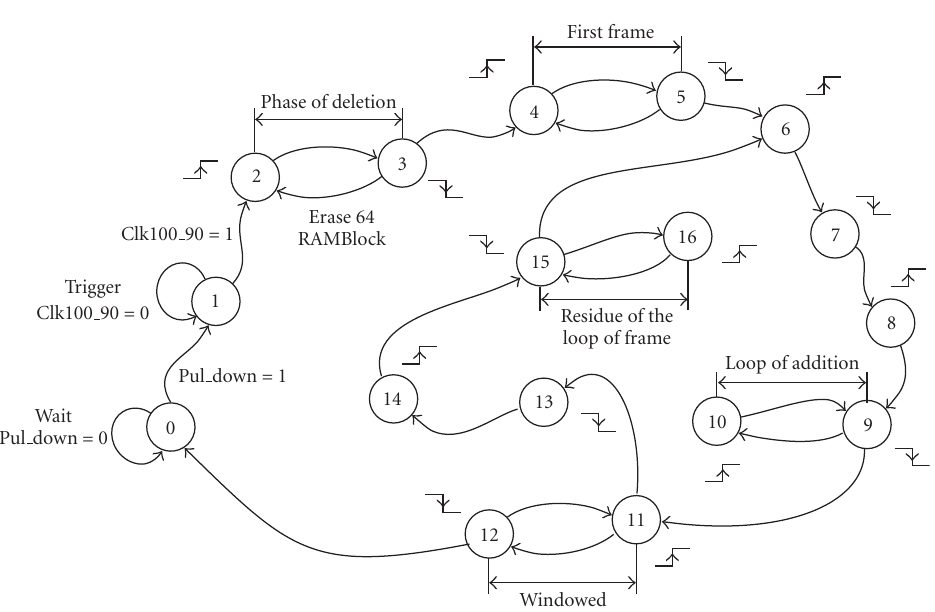
Figure 7: State diagram of the control